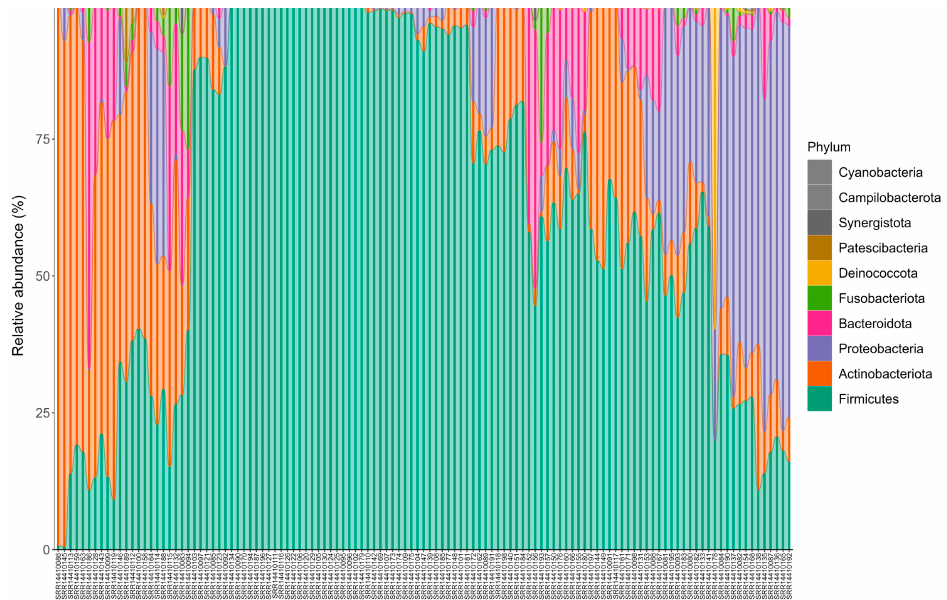
Figure 1. Alluvial plot depicting the taxonomic abundance of ASVs associated with the samples at a phylum level.